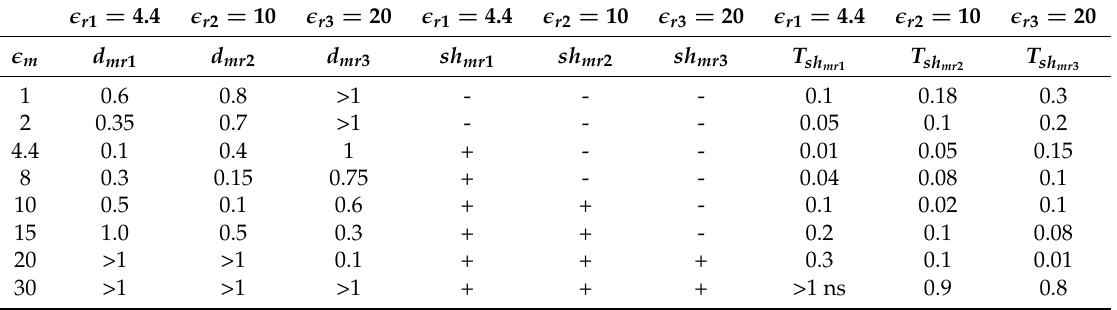
Table 5. Numeric results of simulation realized using configuration shown in Figure 15. d mr represents differential electric field in V obtained in terminals. sh mr represents the phase shift sign obtained on electric field in terminals and T sh is time shift in ns . Sinusoidal signal with f = 1 GHz is used in mr this